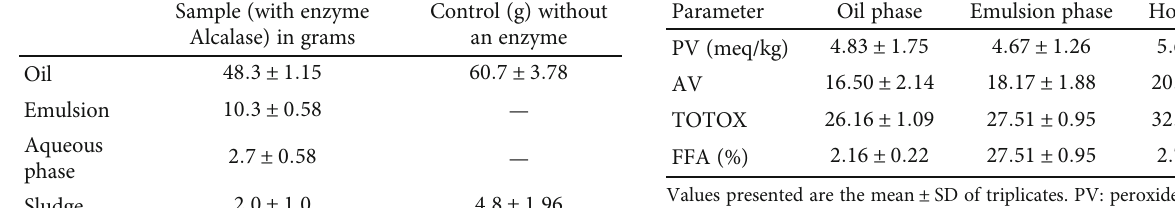
Table 3: Quality parameters of the extracted fi sh oil fractions. Table 2: Wet weight distribution of the fi sh oil fractions. Parameter Sample (with enzyme Control (g) Alcalase) in grams